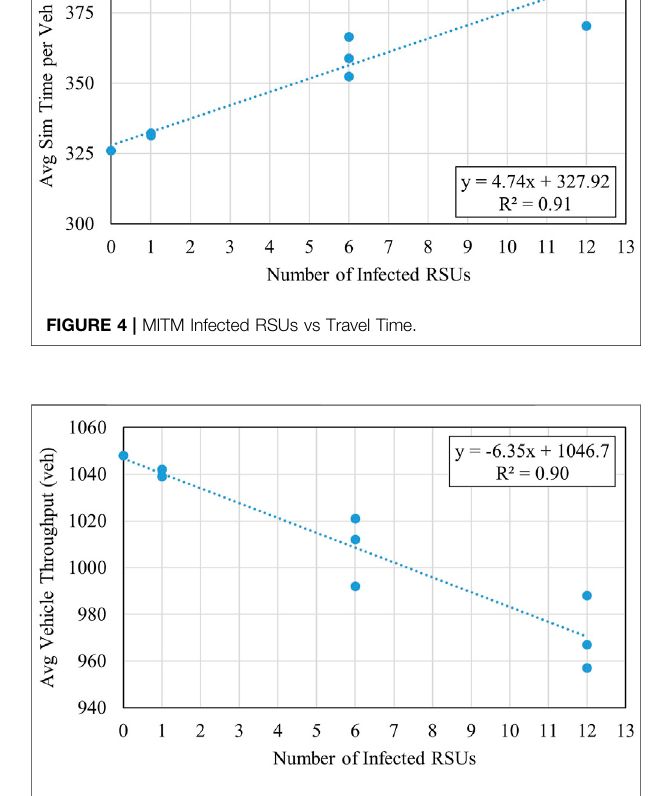
FIGURE 5 | Average throughput per number of infected RSUs — MITM